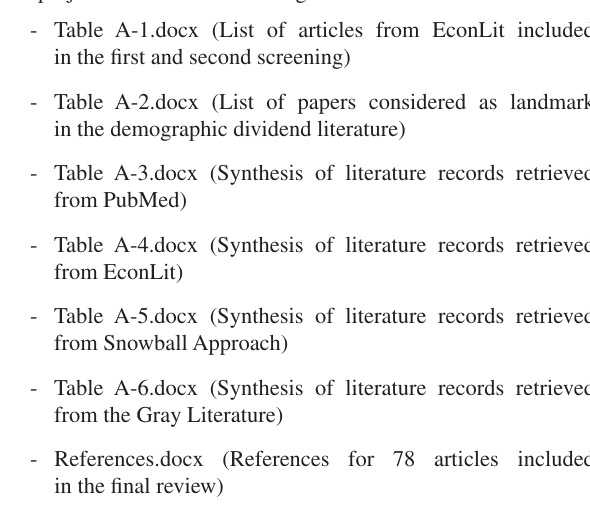
- Table A-1.docx (List of articles from EconLit included in the first and second screening) - Table A-2.docx (List of papers considered as landmark in the demographic dividend literature) - Table A-3.docx (Synthesis of literature records retrieved from PubMed) - Table A-4.docx (Synthesis of literature records retrieved from EconLit) - Table A-5.docx (Synthesis of literature records retrieved from Snowball Approach) - Table A-6.docx (Synthesis of literature records retrieved from the Gray